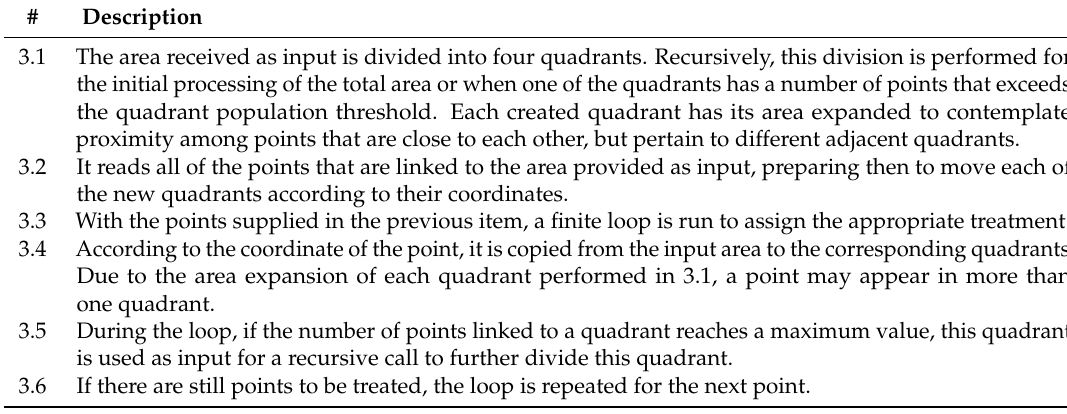
Figure 10. Flow of the recursive space division function in Algorithm 1.1. Source: the authors. Table 5. Steps of the recursive space division function in Algorithm 1.1.